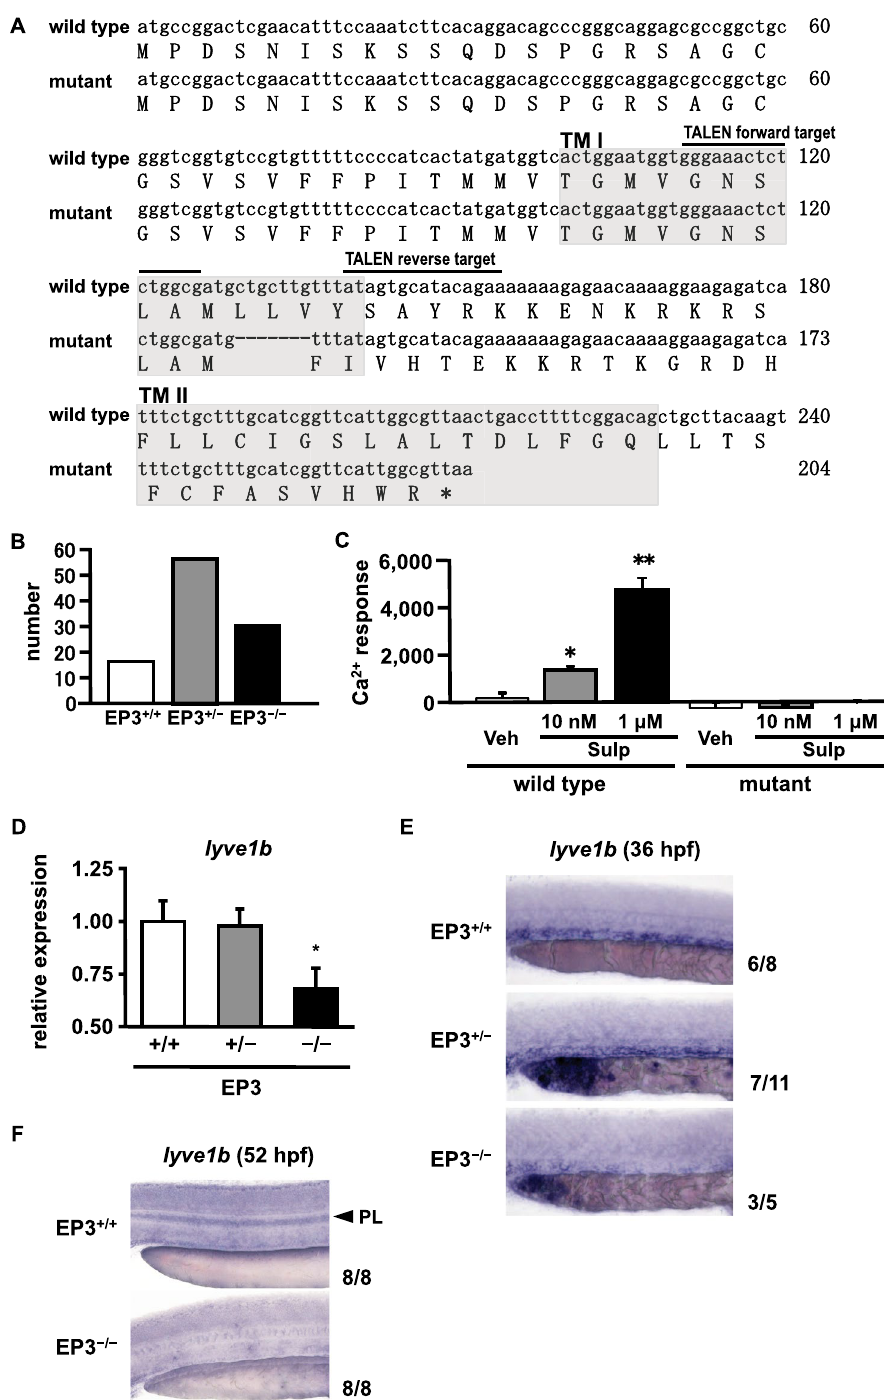
Figure 6. Effect of EP3 receptor deficiency on lymphatic specification and development. ( A ) Sequence alignment of the wild-type and mutant EP3 receptor. The seven base-pair deletion in mutant EP3 receptor is indicated by a dotted line. Transmembrane (TM) regions of the wild-type EP3 receptor are indicated by gray boxes. ( B ) Number of live births of EP3 + / + , EP3 + / − , and EP3 − / − zebrafish. ( C ) HeLa cells were transfected with an expression vector encoding either the wild-type or mutant EP3 receptor. After 24 h, cells were incubated with loading buffer for 1 h and then treated with Veh or Sulp. Induced intracellular Ca 2 + mobilization was evaluated by AUC analysis. * P < 0.05, ** P < 0.01 vs Veh. Each value represents the mean ± SEM (N = 3). ( D ) Relative expression levels of lyve1b were quantified by RT-qPCR in EP3 + / + , EP3 + / − , and EP3 − / − zebrafishs at 24 hpf. Values are shown relative to the value obtained with EP3 + / + . Each value represents the mean ± SEM (N = 8–12) * P < 0.05 vs EP3 + / + . ( E ) Expression of lyve1b was analyzed by WISH in EP3 + / + , EP3 + / − , and EP3 − / − zebrafish at 36 hpf. ( F ) Expression of lyve1b was analyzed by WISH in EP3 + / + and EP3 − / − zebrafish at 52 hpf. The PL is indicated by an arrowhead. The number at the bottom right of each panel indicates the number of embryos demonstrating the phenotype shown in the panel over the total number of embryos analyzed in a representative